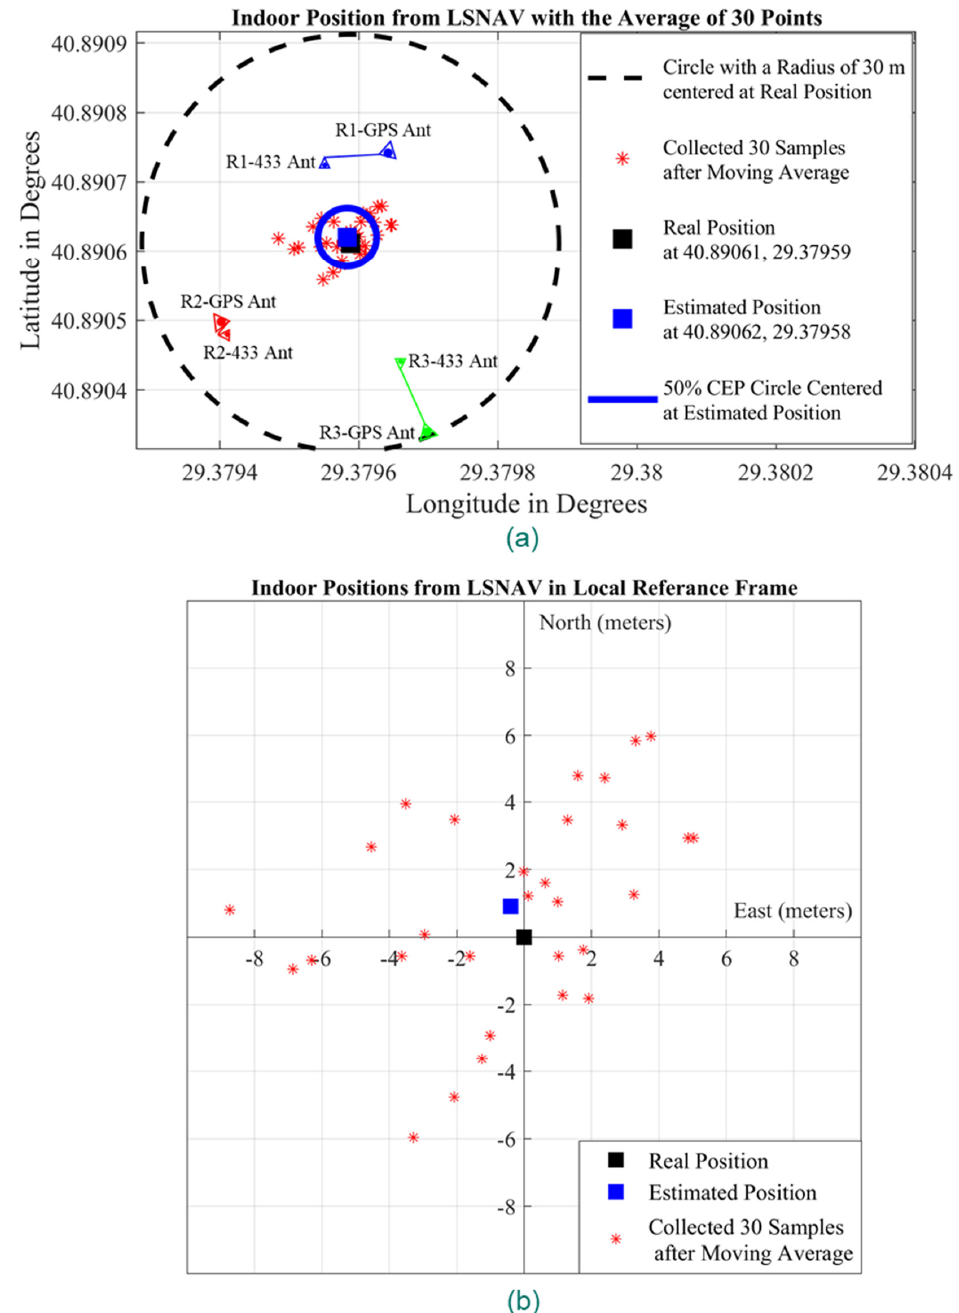
Figure 19. The results of the Experiment 2: ( a ) repeater positions, outdoor GPS antenna positions, collected samples (red dots), real position of the receiver (black square), estimated position (blue square), and CEP (blue circle) on latitude– longitude graph; ( b ) collected samples (red dots), real position of the receiver (black square), estimated position (blue square) on local reference frame whose center is the real position of the receiver.